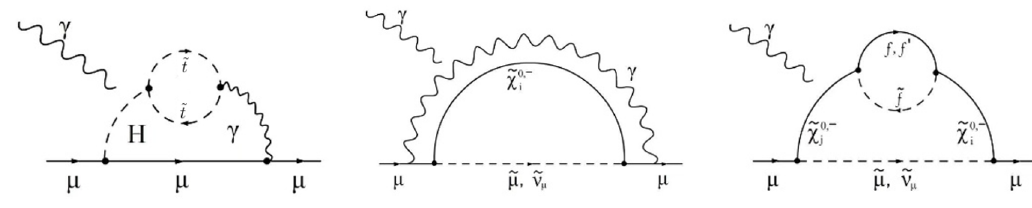
(middle) or a 2L(c) (right) corresponding to SUSY µ µ